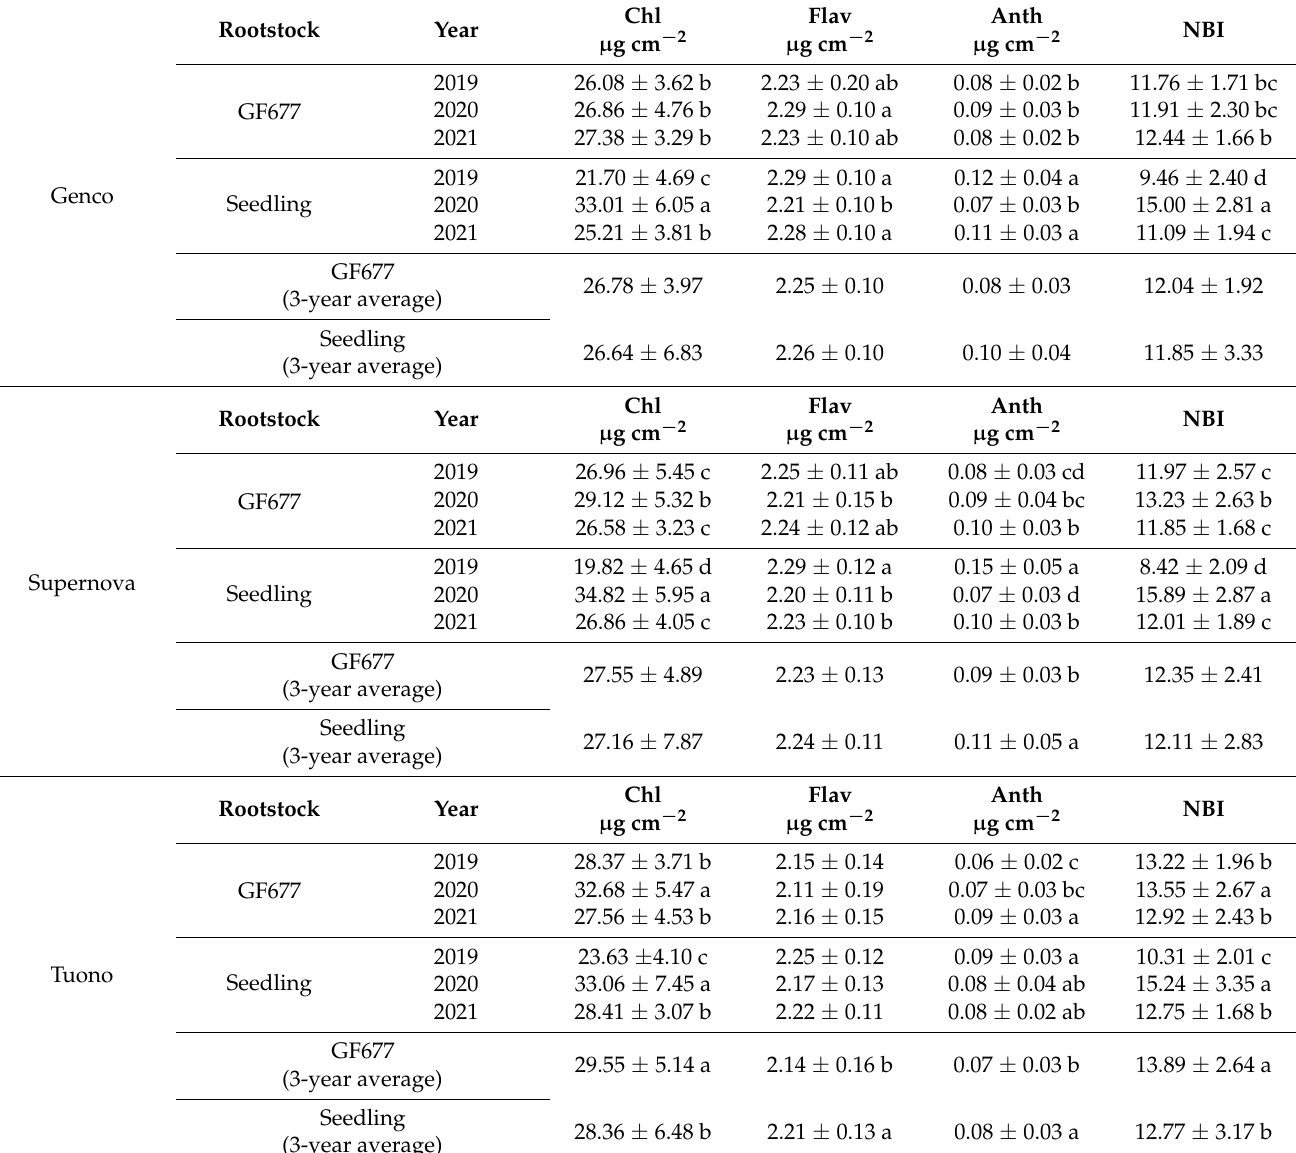
Table 2. Content of total chlorophyll ( µ g cm − 2 ), flavonol ( µ g cm − 2 ) anthocyanin ( µ g cm − 2 ), and nitrogen balance index (NBI) in leaves collected from plants of trial A. Data are reported as mean ± standard deviation per year, and as three-year mean ± standard deviation. Different lowercase letters on the columns indicate significant differences between treatment and year (Fisher’s test p <